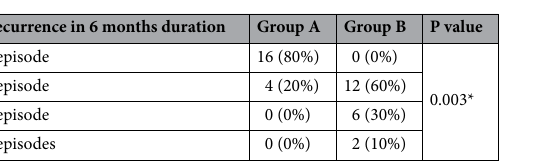
(Table 4, Fig. 1). The number of episodes during 6 months of follow up: in group A who received Vitamin D therapy in addi-